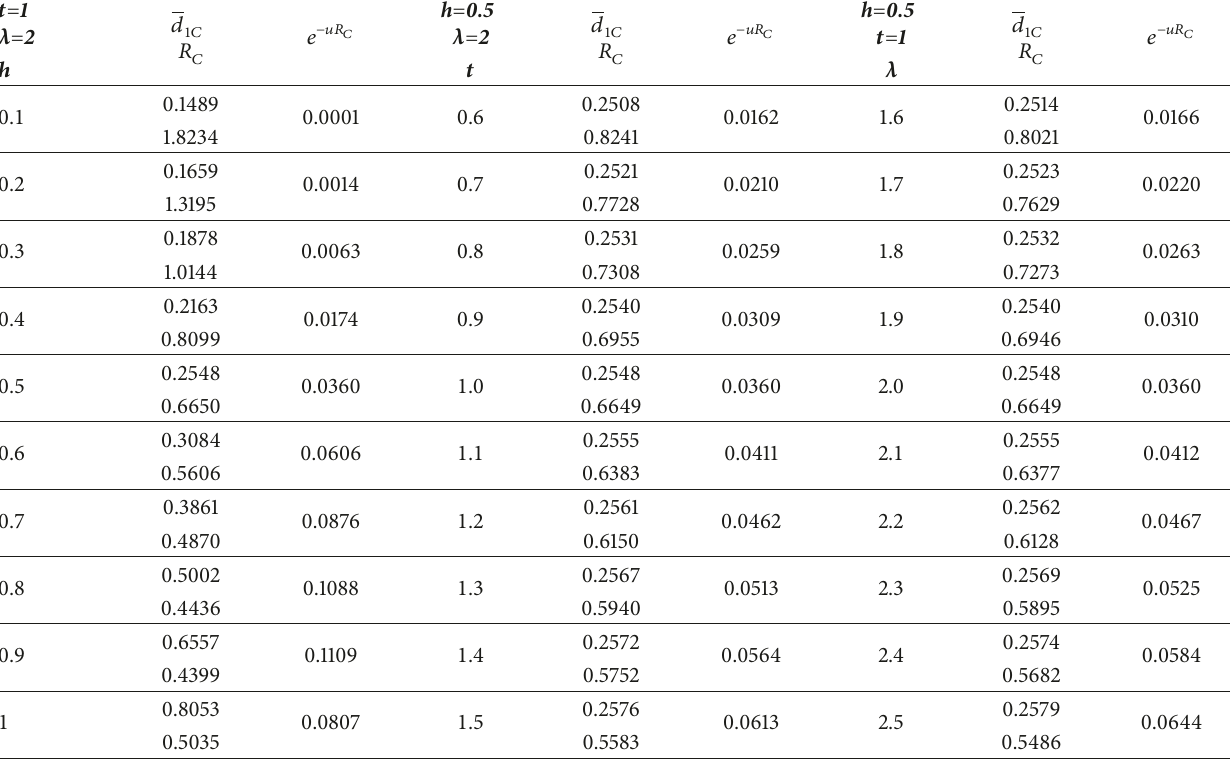
Table 1: Optimal retention levels and the upper bounds with different